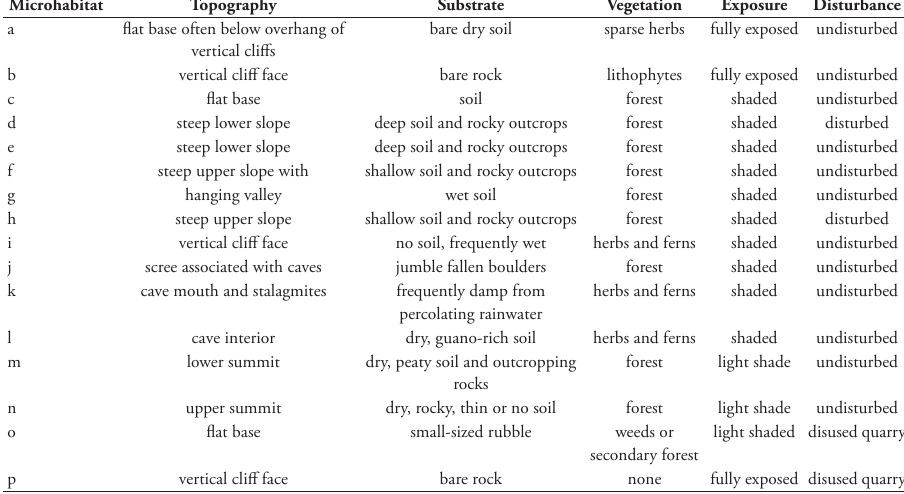
Table 1. Microhabitats on Batu Caves: physical characteristics and level of disturbance. Microhabitat Topography